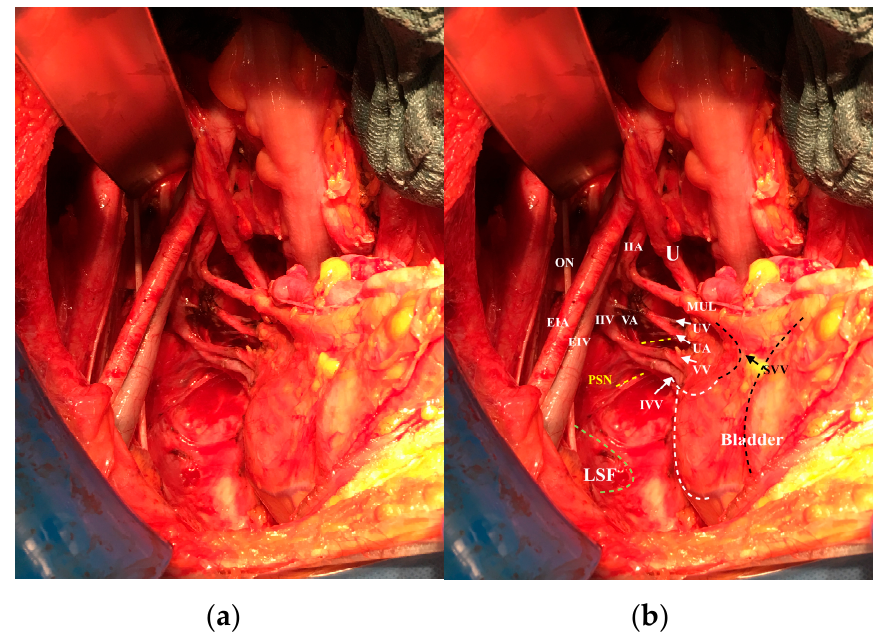
Figure 1. The lateral parametrium and paracolpium after removing the lymph nodes and fat tissue: ( a ) original photo; ( b ) with explanation of anatomic structures: U: ureter, MUL: medial umbilical ligament, IIA: internal iliac artery, IIV internal iliac vein, EIA: external iliac artery, EIV: external iliac vein, ON, obturator nerve, IVV: inferior vesical vessels (the dotted white line shows the distribution of these vessels in the bladder wall), SVV: superior vesical vessels (dotted black line shows the distribution of these vessels in the bladder wall), UV: uterine vein, UA: uterine artery, VV: vaginal vein, VA: vaginal artery, PSN: pelvic splanchnic nerves, LSF: lesser sciatic foramen.